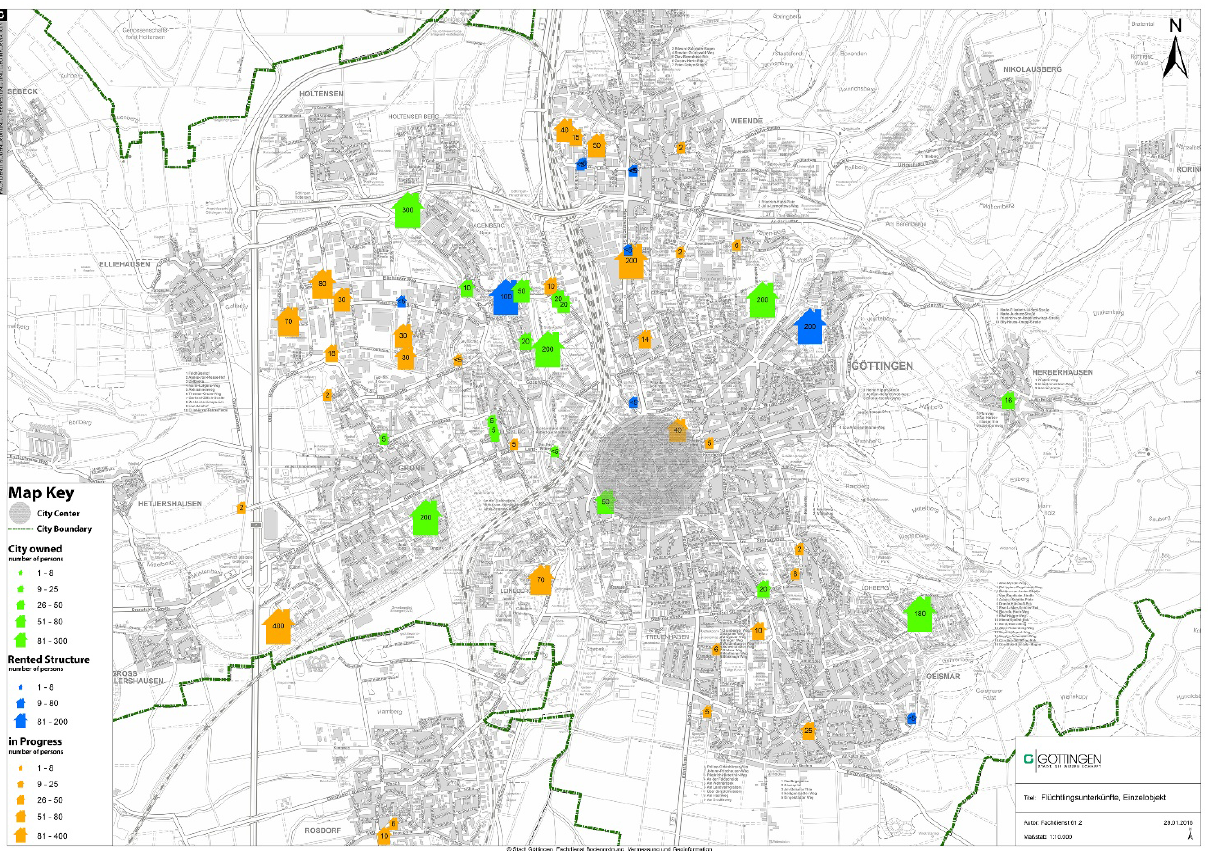
Figure 3. Refugee accommodations’ sizes and distribution in Göttingen in 2016. Many have been closed since. Source: translated from the plan published by the Göttingen City website in